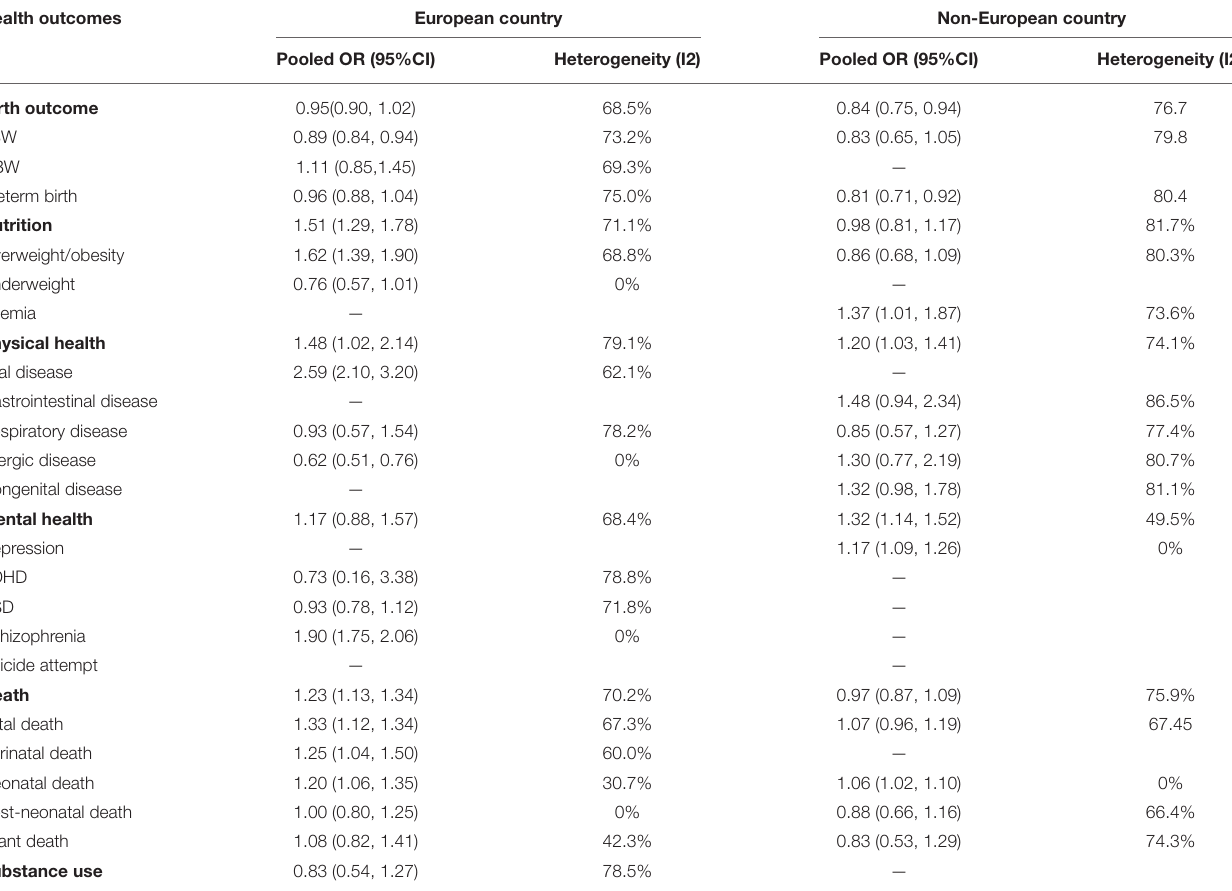
TABLE 2 | The subgroup analyses by study